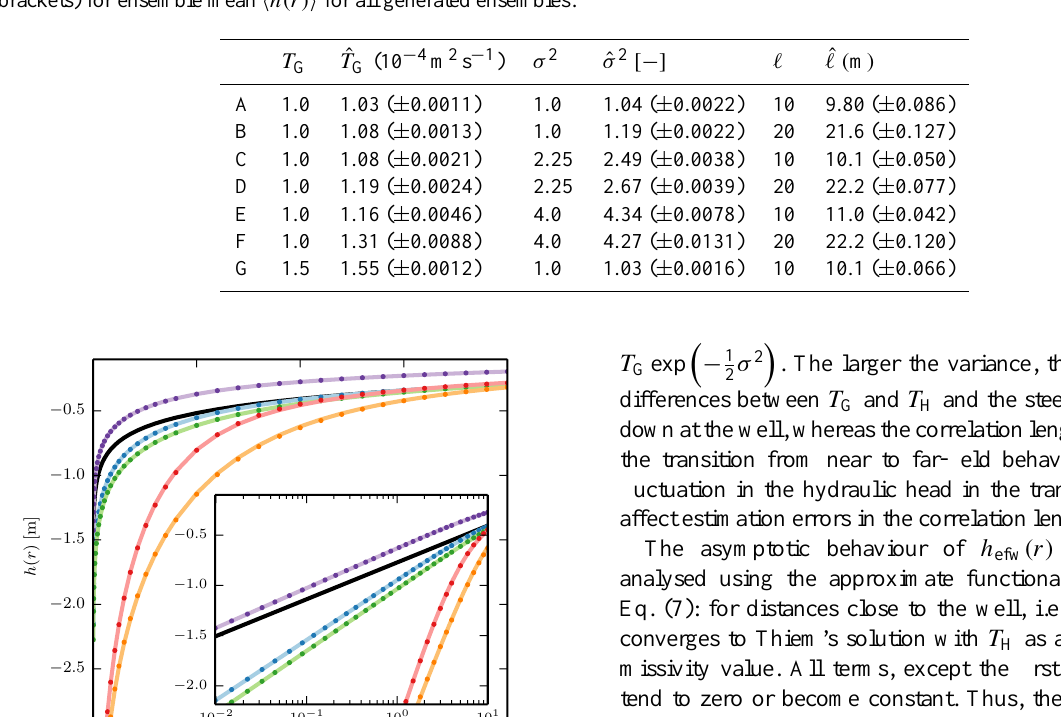
Table 1. Ensemble input parameters T G , σ 2 , and (cid:96) and best-fitting inverse estimation results ˆ T G , ˆ σ 2 , and ˆ (cid:96) with 95% confidence intervals (in brackets) for ensemble mean (cid:104) h(r) (cid:105) for all generated ensembles.